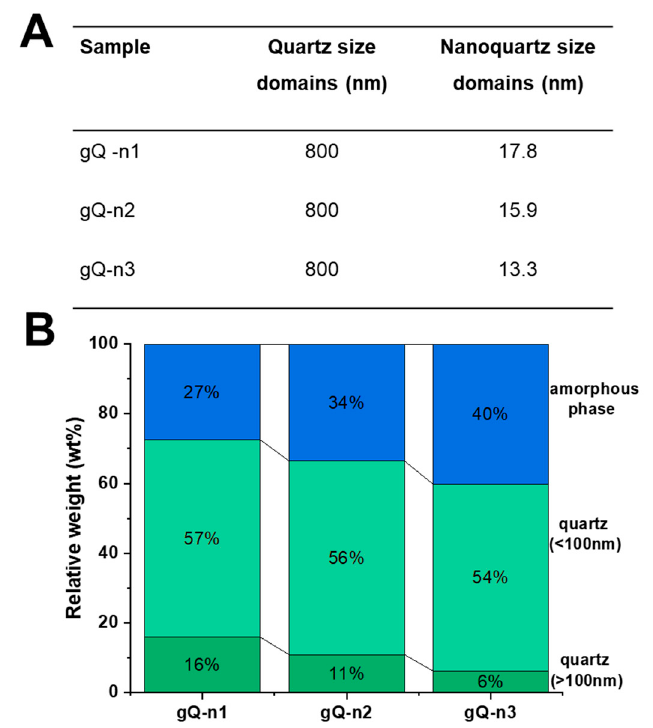
Figure 4. Crystallite size domains ( A ) and relative numbers (wt.%, ( B )) of submicron (>100 nm), nano (<100 nm), and amorphous phases of nanoquartz samples (gQ-n1, gQ-n2, and gQ-n3), calculated by Rietveld refinement of XRPD diffractograms.